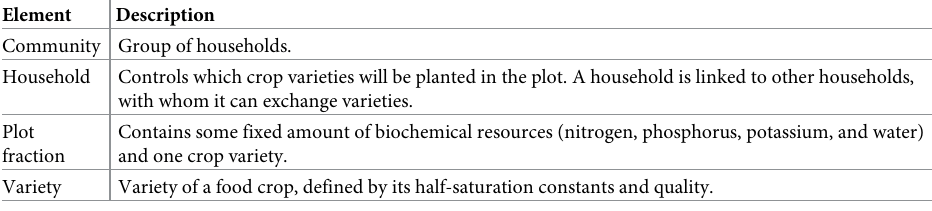
Table 1. Description of the model’s four elements: Land fragment, household, community and variety. Element